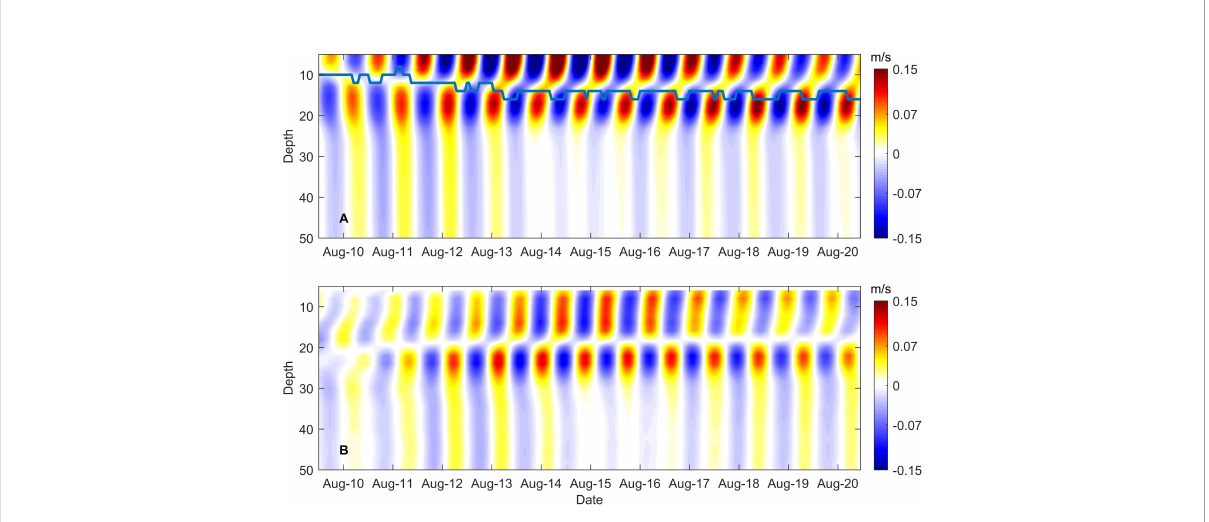
FIGURE 5 Modelled (A) and observed (B) near-inertial velocities (m/s) at the mooring site. The blue line in the (A) denotes the depth of the maximum strati fi cation of the